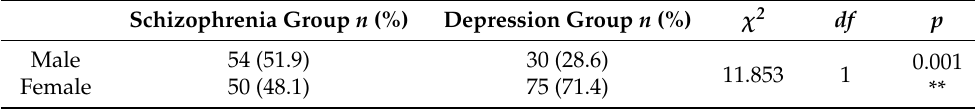
Table 3. The difference in gender between the two